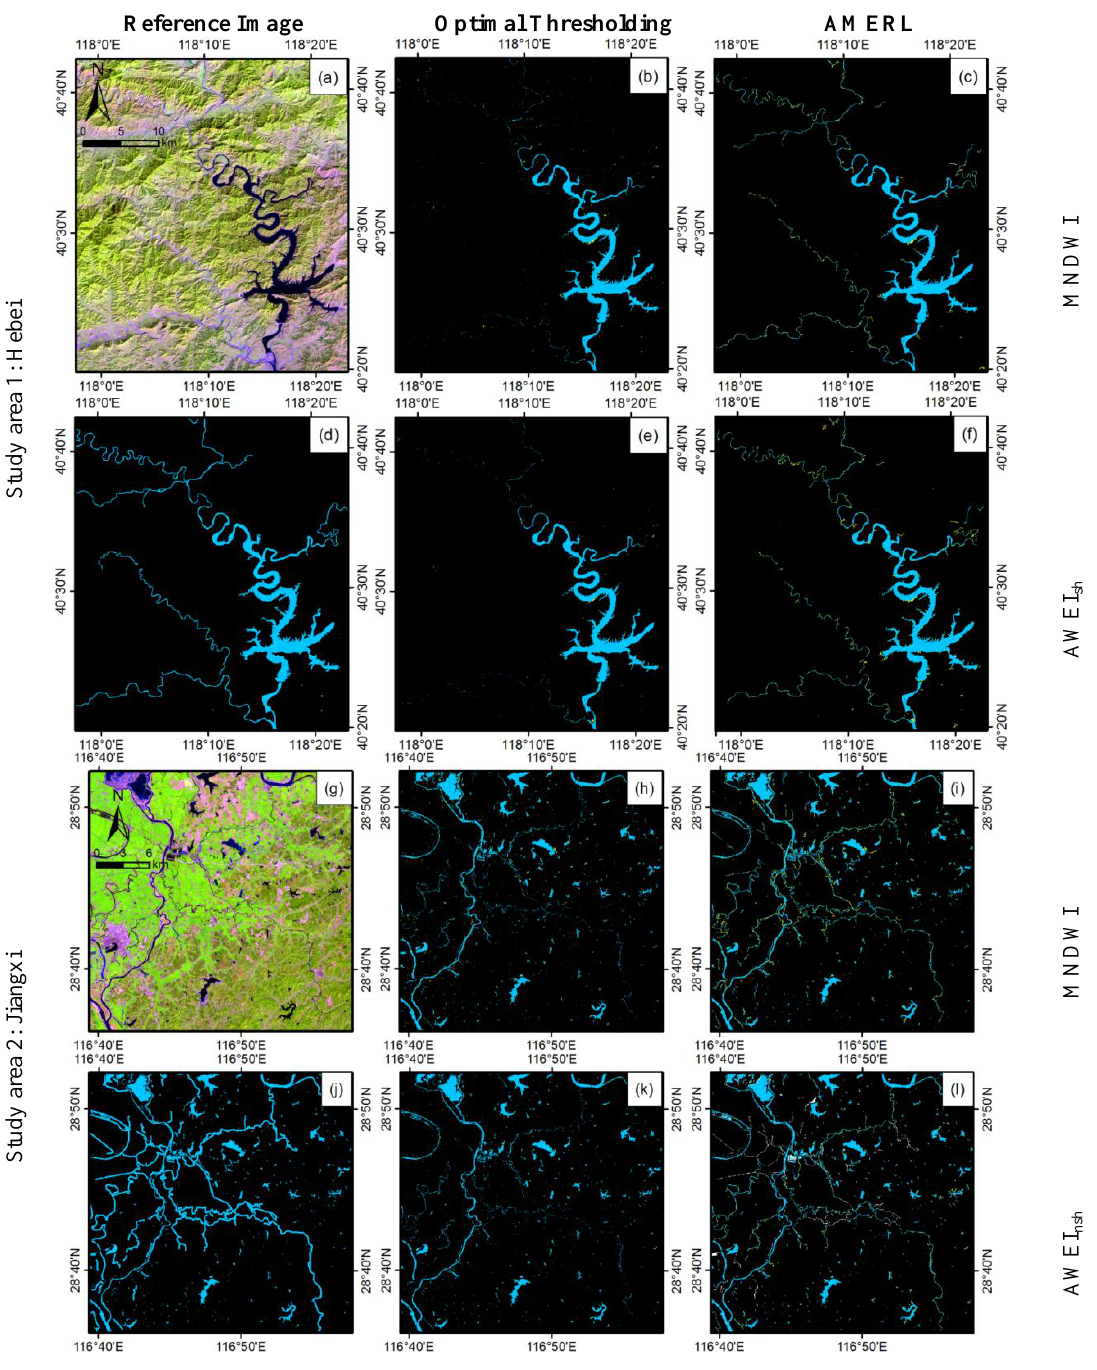
Figure 7. Comparison of reference images ( left ) with the water body mapping results using the optimal thresholding method ( middle ) and the AMERL ( right ). The images are labeled with the name of the study area (to the left of the images) and the WI used in the extraction (to the right of the images). Note that for demonstration purposes, the results of only two WIs are provided for each study area. The reference images are TM/ETM+ 543 band false-color images ( a,g,m ) and manually interpreted results images ( d,j,p ). Note that the manually interpreted results ( d,j,p ) have been vectorized in order to exhibit the spatial distributions of the narrow rivers more